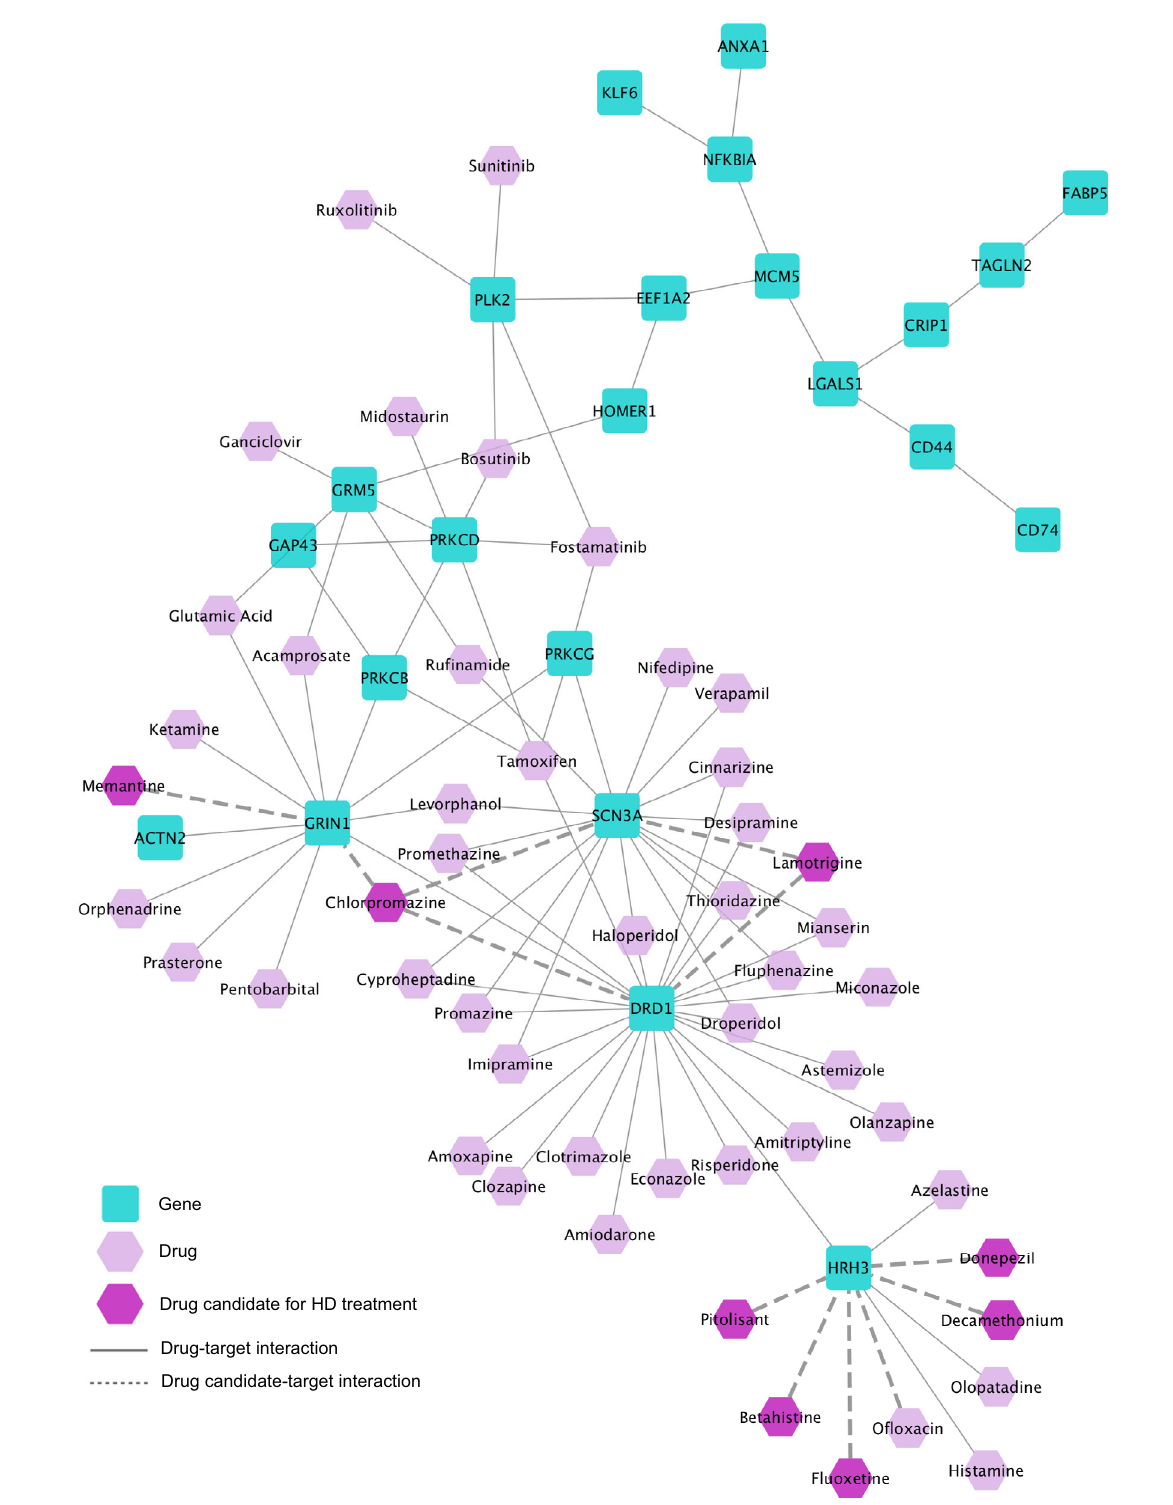
Fig. 5 The Huntington ’ s disease module and its targeting top-ranked drugs. The HD disease module derived by BiCoN using gene expression data, together with its targeting 50 top-ranked